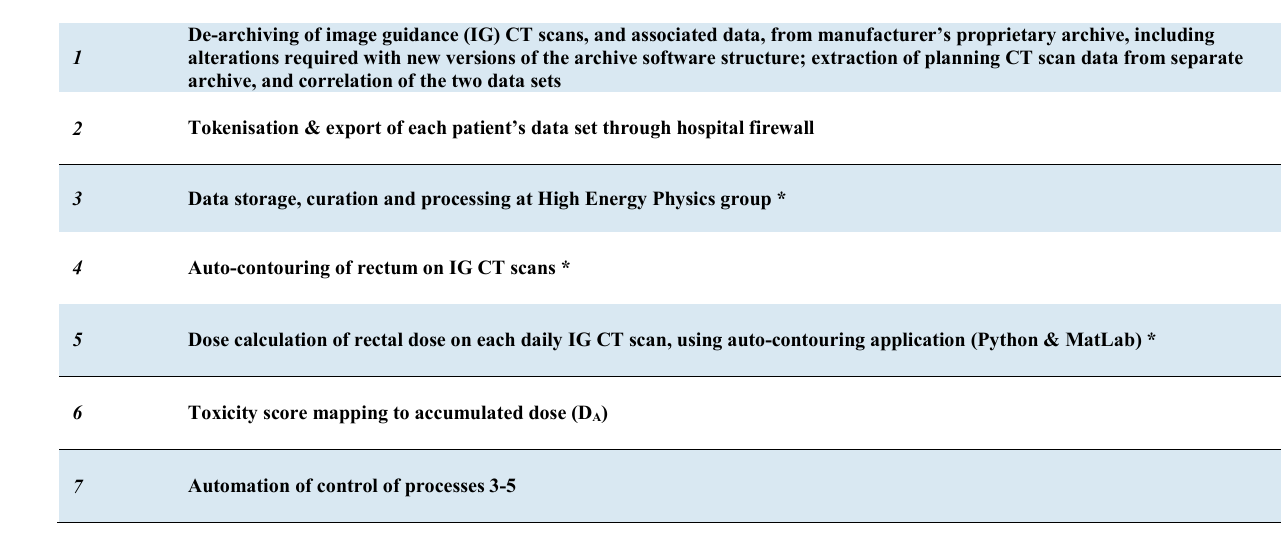
Tab. 1. Areas of interaction required between the clinical and the physics environment. The major challenges are shown with ‘*’. The first was the general challenge of handling volumes of data, originally estimated to total approximately 4 TB, which was too large to be managed within the radiotherapy centre. Not only storage, but also curation and processing of the data, was required (Figure